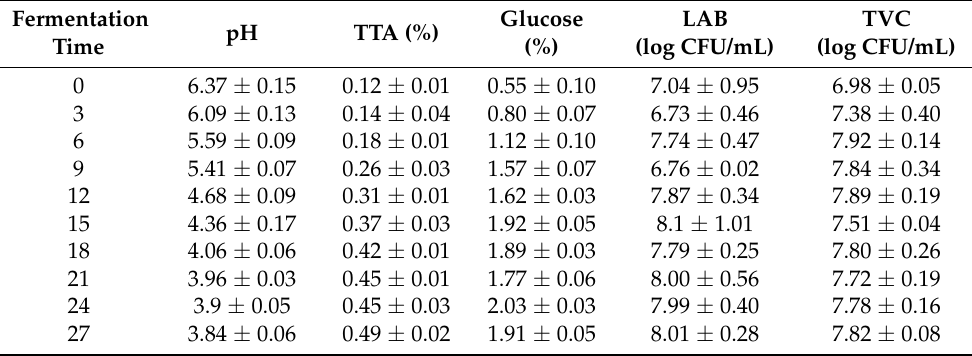
Table 1. Physicochemical and microbial properties of pearl millet slurry during fermentation *.